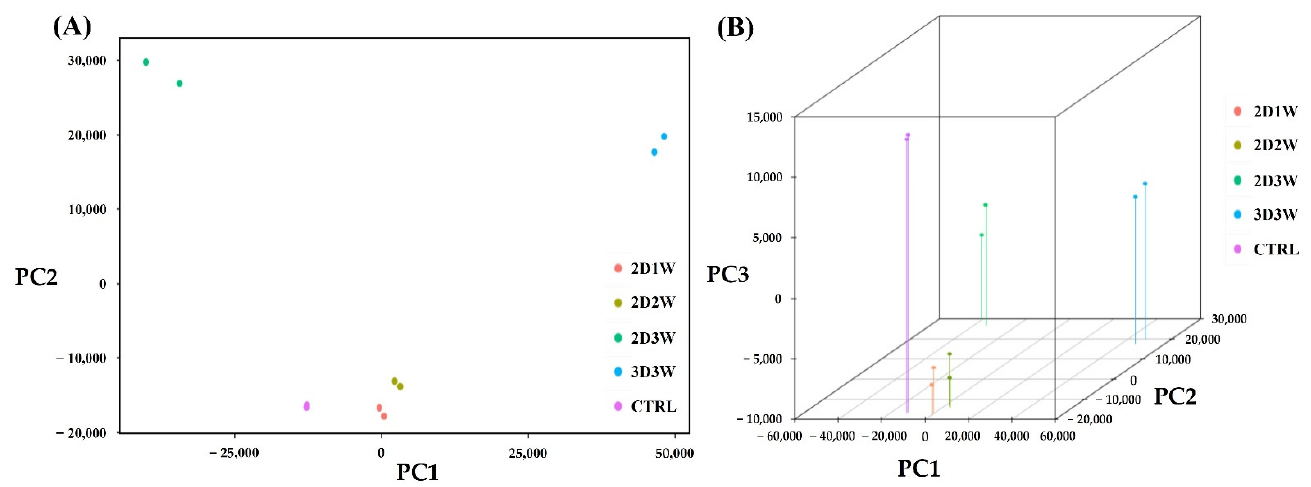
Figure 3. Principal component analysis of osteogenic differentiated samples in 2D condition (one, two and three weeks) and 3D condition (three weeks). ( A ) Two-dimensional scatter plot for principal components. ( B ) Three-dimensional scatter plot for three principal components.